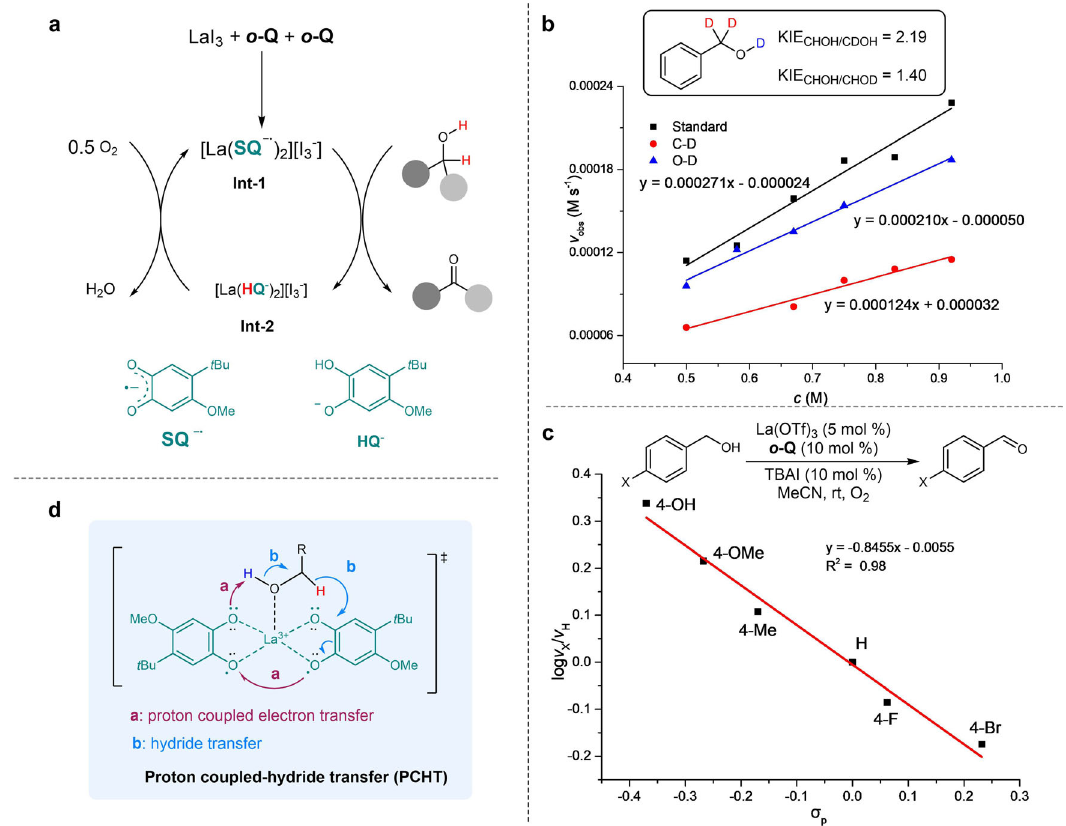
Fig. 7 Proposed catalytic cycle and kinetic studies. a Proposed catalytic cycle. b Kinetic isotope effects of benzyl alcohol 1a. c Hammett correlation of para -substituted benzyl alcohols. d Proposed proton-coupled hydride transfer